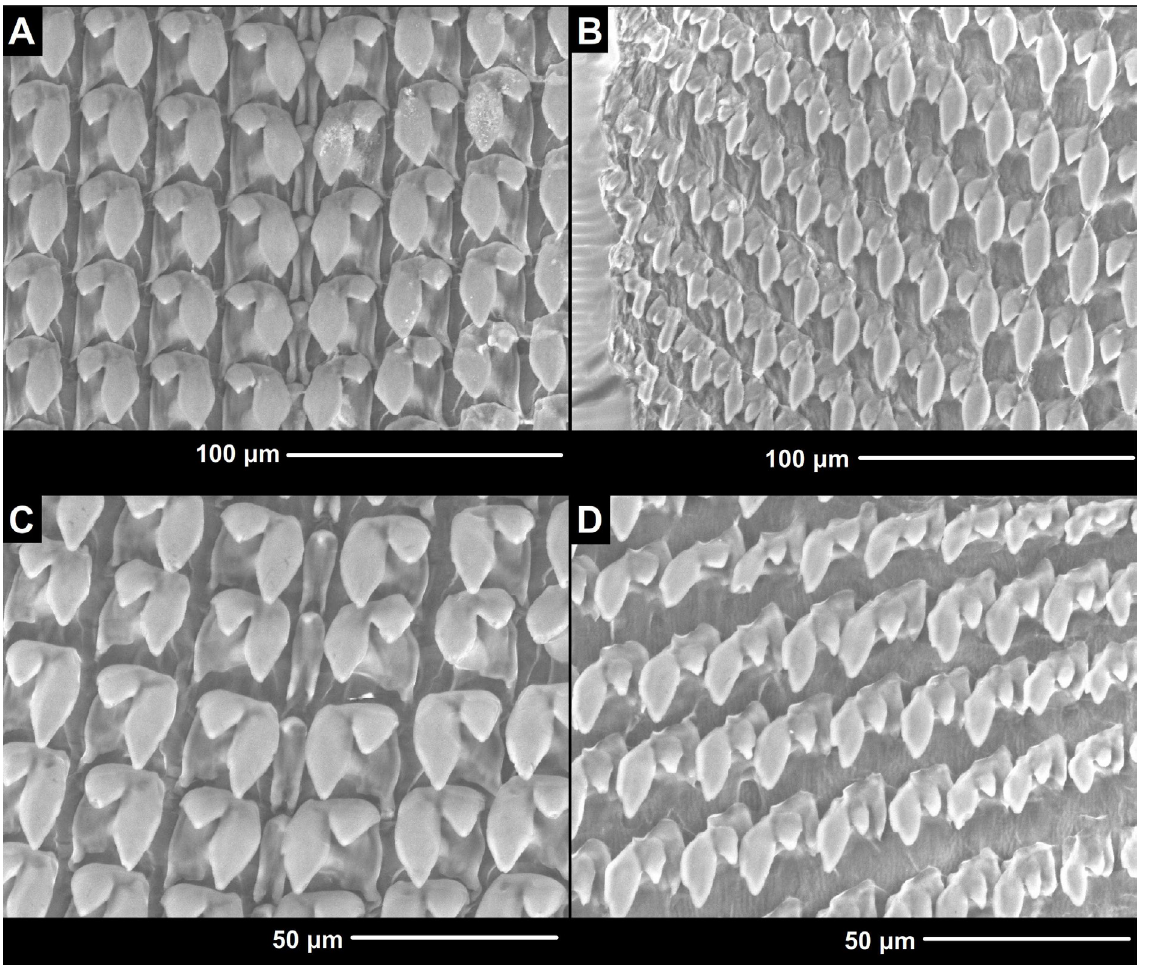
Fig. 11. Radula of Chersaecia Gude, 1899. A, C . Central and first lateral teeth. B, D . Marginal teeth. A–B . C. dextrorsa (Benson, 1860) (UF 76385). C–D . C. reversalis sp. nov. (UF 347047). All images: B.